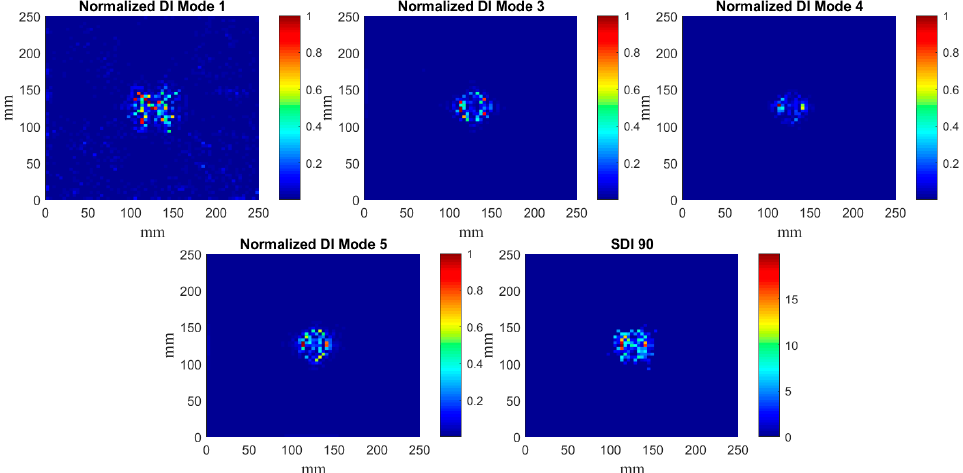
Figure 10. The determined normalized DIs for the mode shapes for the plate {3} and SDIs with the 90% confidence level.